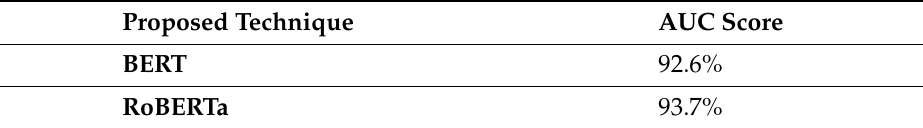
Table 15. BERT and RoBERTa AUC